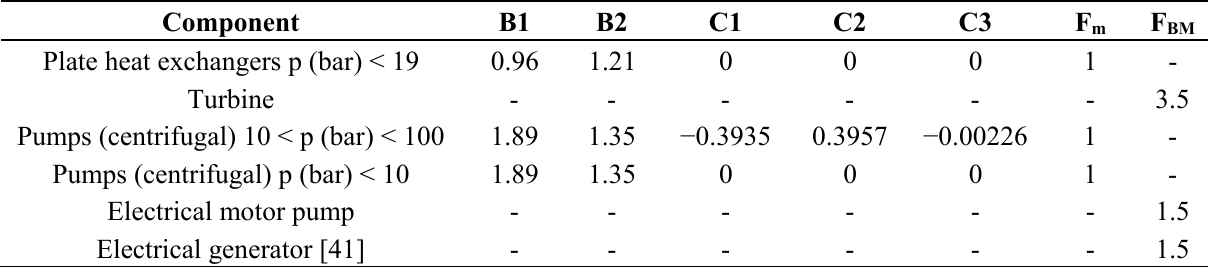
Table 6. Pressure factor, material factor and bare module cost